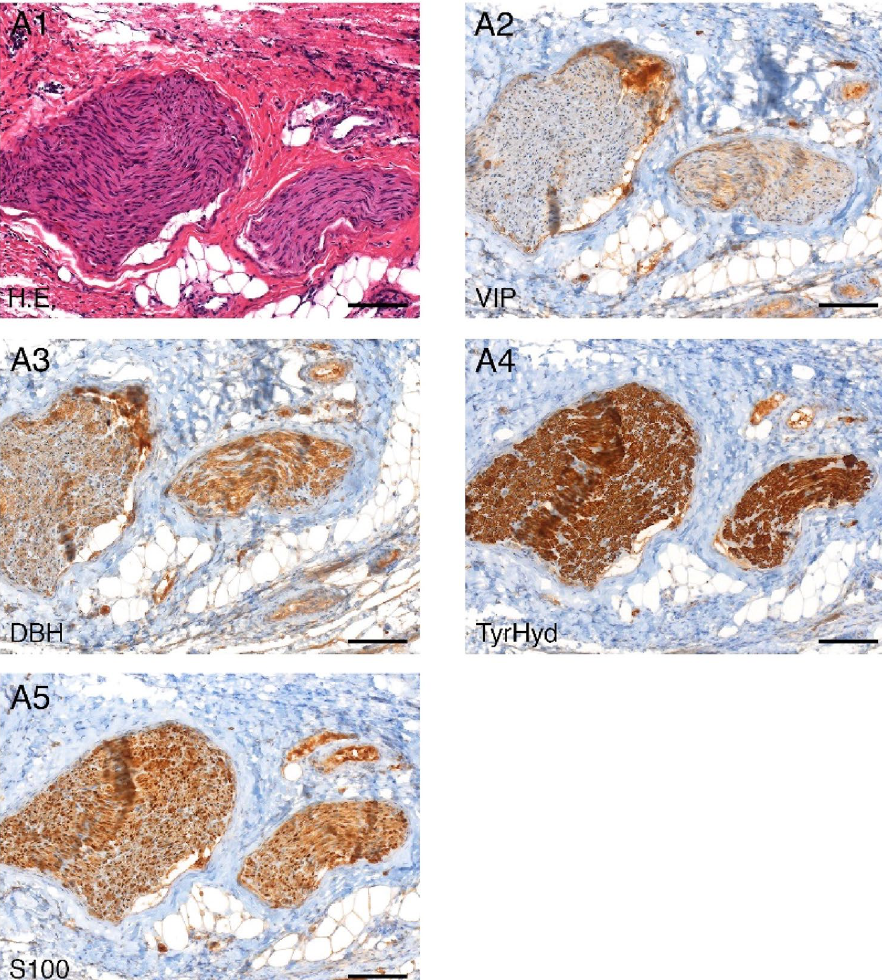
A4 thyrosin-hydroxylase (TyrHyd) staining, A5 S100 staining, tenfold